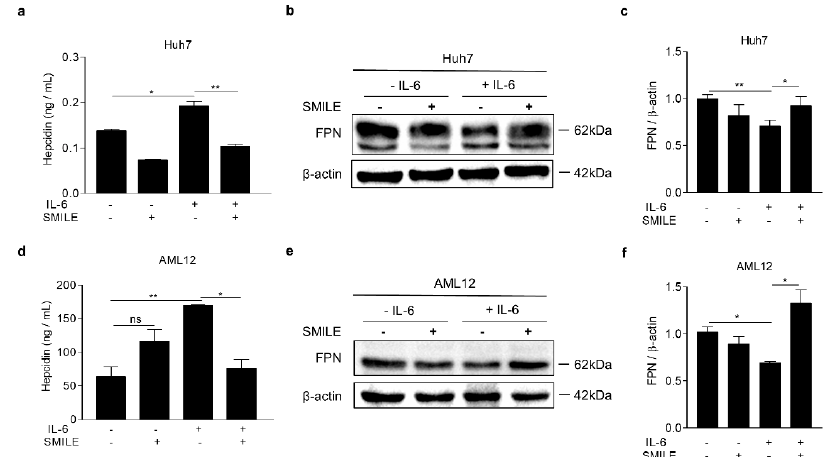
Figure 2. SMILE suppresses IL-6-induced hepcidin secretion. ( a – f ) Huh7 and AML12 cells were transfected with vector encoding SMILE (5 μ g) and treated with IL-6 for 12 h after 2 h of serum starvation. Secreted hepcidin was measured using ELISA from culture medium. Ferroportin (FPN) expression was analyzed using western blot. Hepcidin secretion ( a ), FPN expression ( b ) and graphical representation ( c ) in Huh7 cells. Hepcidin secretion ( d ), FPN expression ( e ) and graphical representation ( f ) in AML12 cells. All gels for western blot analysis in ( b , e ) were run under the same experimental conditions including equal amounts (100 µ g) of protein. The independent experiments were repeated at least three times. The values are presented as means ± SD. ns; not significant. * P < 0.05, ** P < 0.01 using two-tailed Student’s t